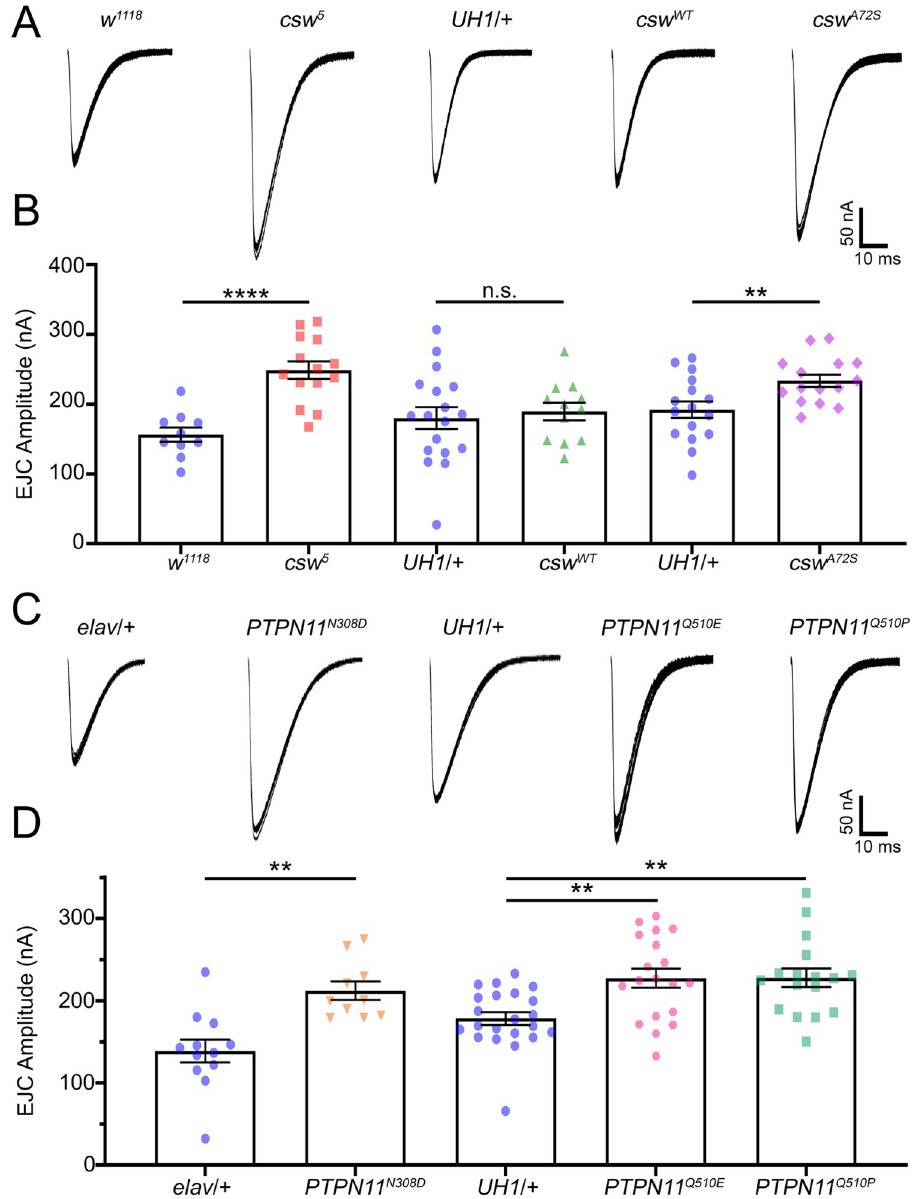
Fig 1. Both loss- and gain-of-function csw / PTPN11 mutants elevate NMJ transmission. TEVC recordings of nerve- stimulated evoked neurotransmission in both LoF and GoF mutations of Drosophila csw and human PTPN11 mutations from NS/NSML patients. ( A) Representative EJC traces for the csw mutant comparisons showing 10 superimposed evoked synaptic responses (1.0 mM Ca 2+ ) from w 1118 genetic background control, csw 5 null mutant, transgenic driver control ( UH1 -Gal4/ w 1118 ), wild-type csw ( UH1 -Gal4 > csw WT ), and csw A72S GoF mutant ( UH1 - Gal4 > csw A72S ). ( B) Quantification of the mean EJC amplitudes in all 5 genotypes using two-sided t tests. ( C) Representative evoked EJC traces for the human patient PTPN11 mutations showing 10 superimposed responses in paired control ( elav -Gal4/ w 1118 ) and GoF mutant ( elav -Gal4 > PTPN11 N308D ; left), and control ( UH1 -Gal4/ w 1118 ) and LoF mutants ( UH1-Gal4 > PTPN11 Q510E and PTPN11 Q510P ; right). ( D) Quantification of the mean EJC amplitudes in all 5 genotypes using two-sided t test, Kruskal–Wallis and Dunn’s multiple comparisons. The scatter plots show all of the individual data points as well as mean ± SEM. N = number of NMJs. Significance shown as: p > 0.05 (not significant, n.s.), p < 0.001 ( �� ) and p < 0.0001 ( ���� ). The data underlying this figure can be found in S1 Data. csw AU : AbbreviationlistshavebeencompiledforthoseusedinFigs 1 (cid:0) 6 : Pleaseverifythatallentriesarecorrect : , corkscrew ; EJC, excitatory junction current; GoF, gain-of-function; LoF, loss-of-function; NMJ, neuromuscular junction; NS, Noonan syndrome; NSML, NS with multiple lentigines; PTPN11 , protein tyrosine phosphatase non- receptor type 11; TEVC, two-electrode